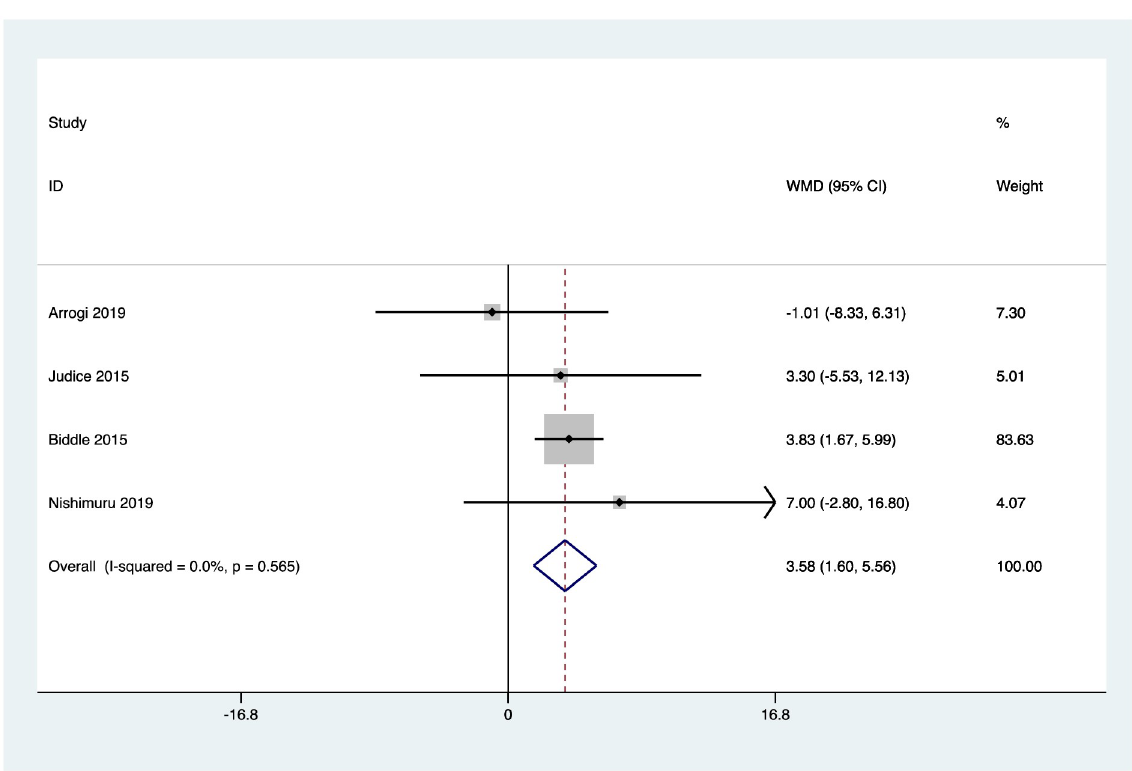
Fig 5. activPAL mean daily rate of sedentary breaks. Heterogeneity chi-squared = 2.04 (d.f. = 3) p = 0.565; I-squared (variation in WMD attributable to heterogeneity) = 0.0%; Test of WMD = 0: z = 3.55 p = 0.000.